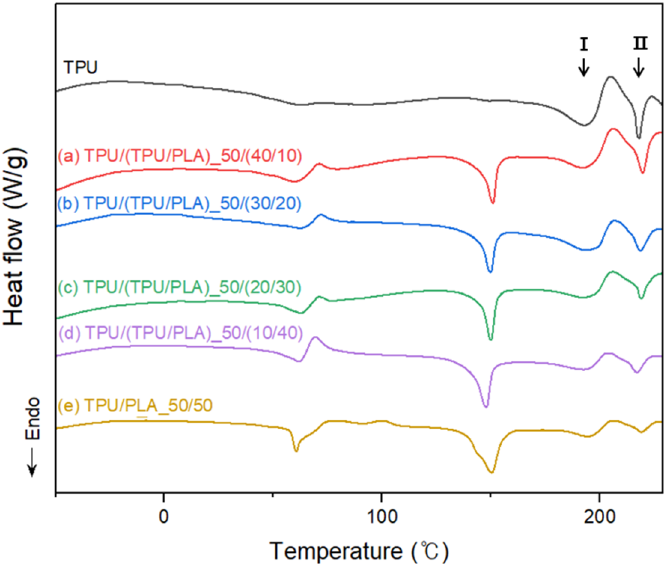
Figure 9. DSC thermograms of TPU fiber and TPU/(TPU/PLA) side-by-side bicomponent fibers ((a)–(e)). Two endothermic peaks(I, II) indicate the melting points of TPU. Table 3. DSC characterization studies of TPU fiber and TPU/(TPU/PLA) side-by-side bicomponent fibers ((a)–(e)).